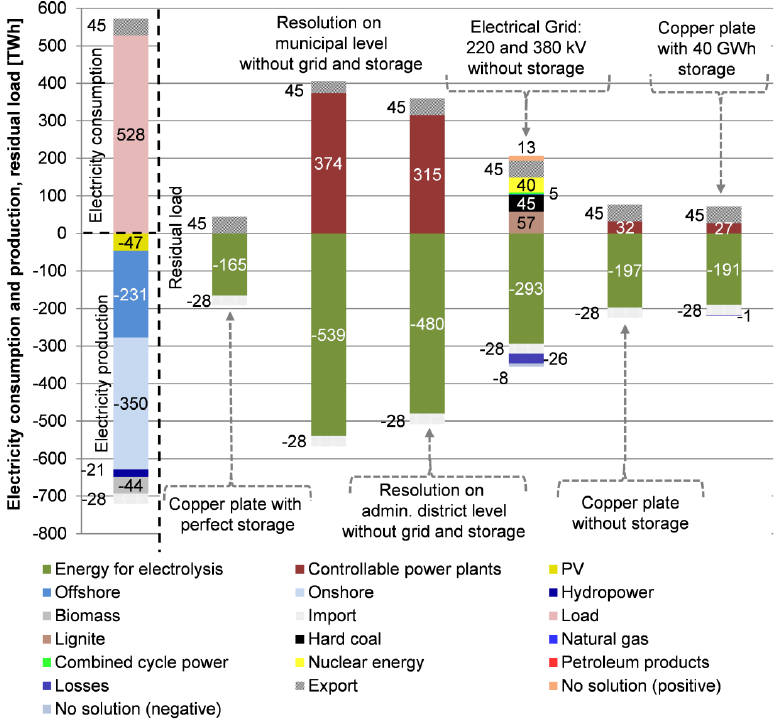
Figure 11. Electricity production, electricity demand and residual energy with six different input assumptions.